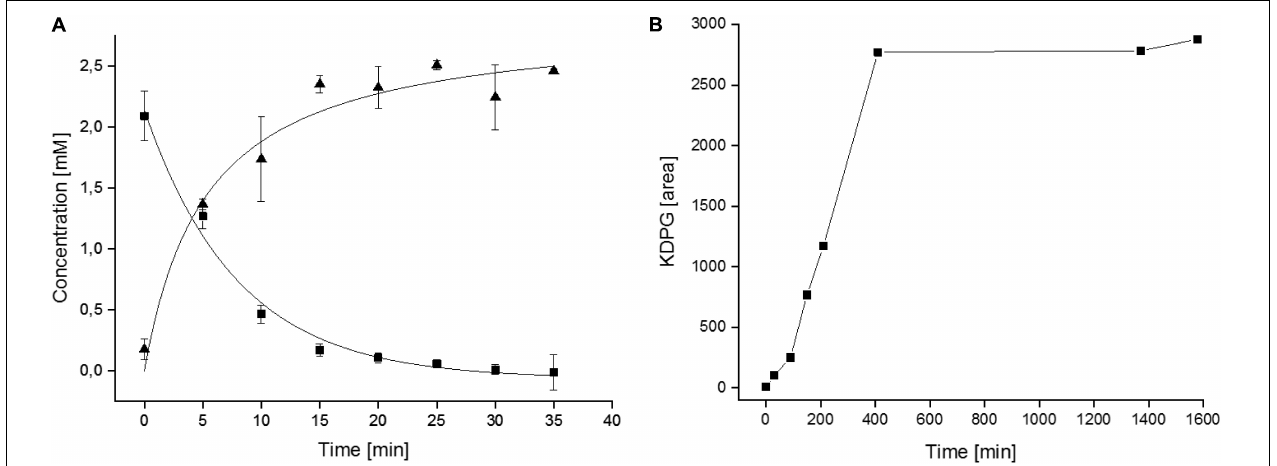
FIGURE 5 | Kinetics of the Cc EDD mediated 6PG conversion to KDPG. (A) Enzymatic determination of 6PG consumption and KDPG formation during the small scale conversion assays. (B) HPLC-MS determination of the KDPG formation (given as increasing peak area in arbitrary units) during lab scale synthesis of KDPG from 6PG.